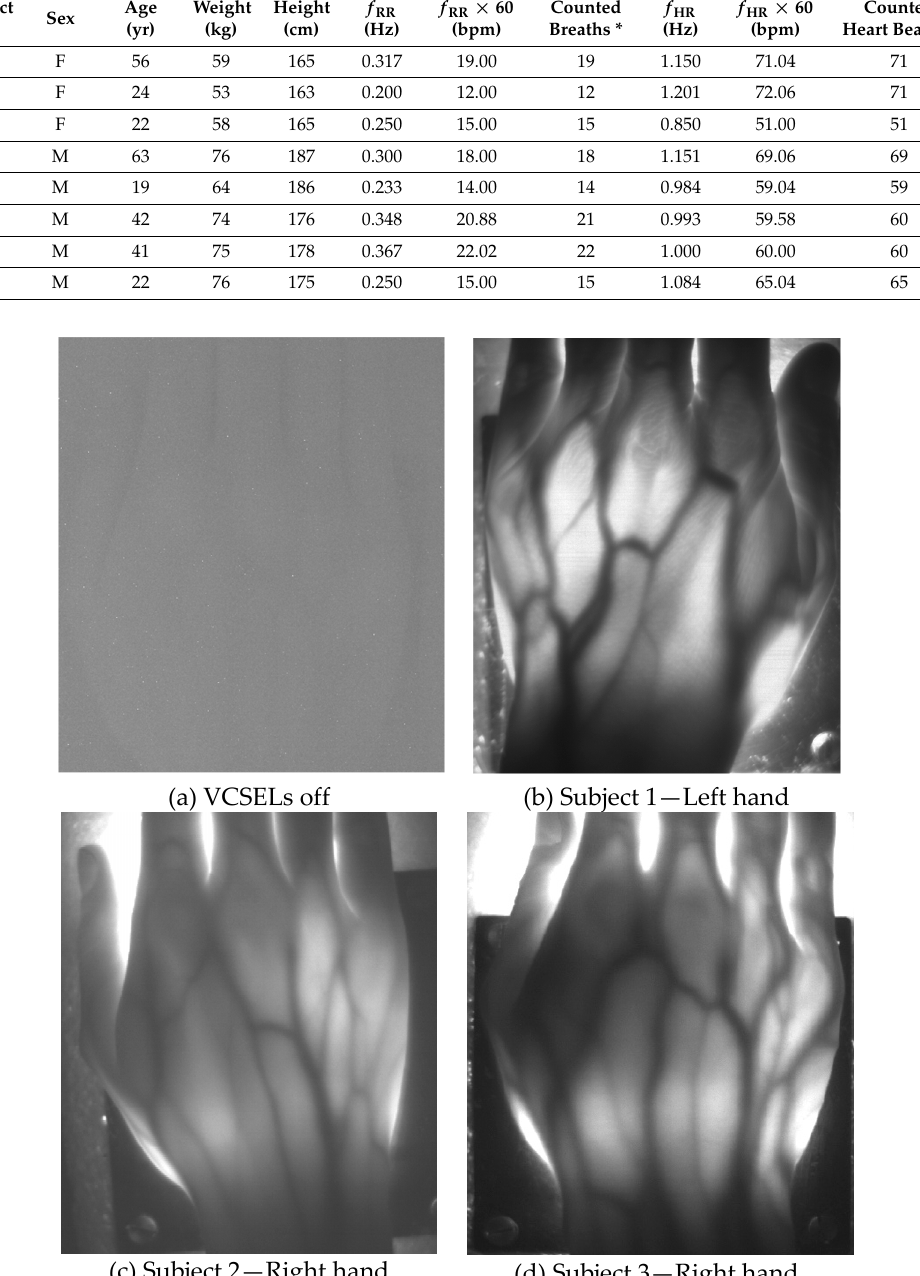
Figure 4. Raw pictures acquired with the transillumination system on white-skin, female subjects 1, 2 and 3, in standard ambient day-light. ( a ) Picture acquired with VCSELs off; ( b )–( d ) Pictures acquired with VCSELs on, where morphological details are well visible.